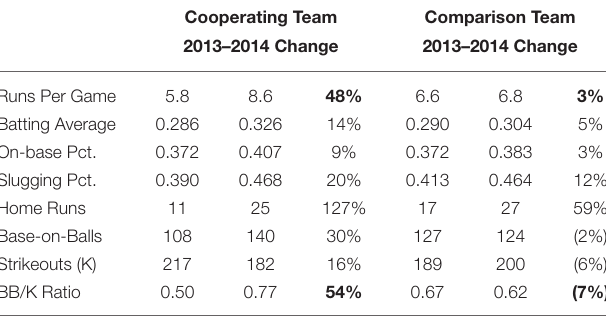
TABLE 2 | Changes in Batting Statistics: Cooperating Team vs. Comparison Team.